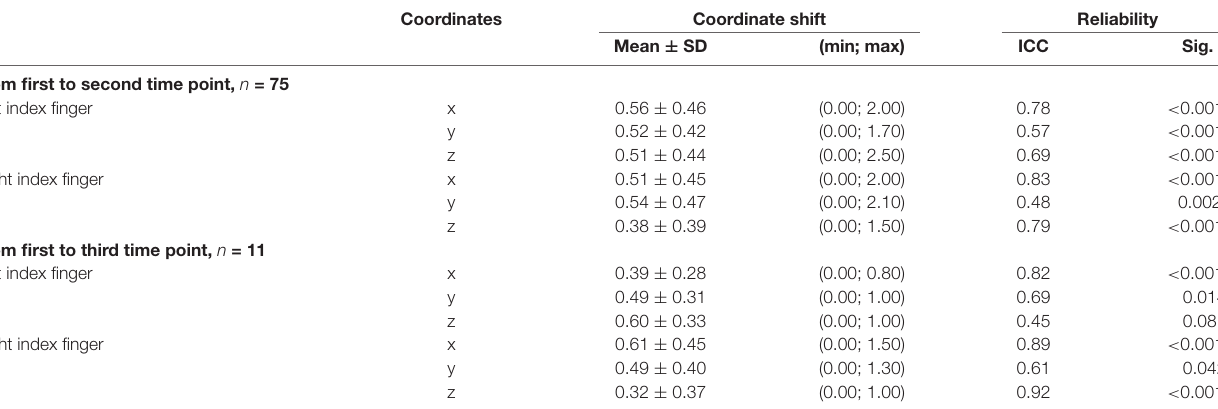
TABLE 2 | Shift of single activation peak coordinates and the respective interclass correlation coefficient.